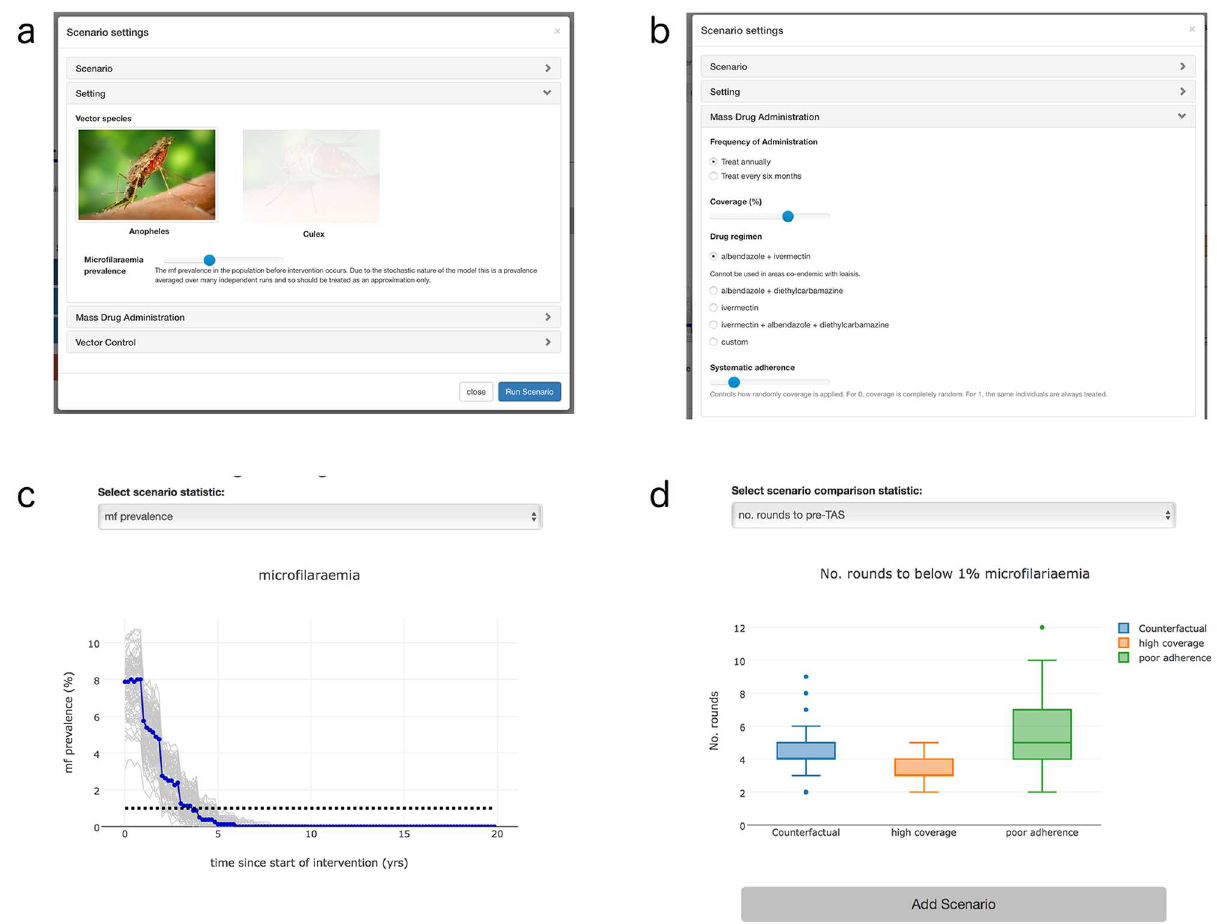
Fig 1. Overview of modelling tool. (a) Selectionpanel used to design scenario.Dominantvector species can be selectedand baseline prevalenceis controlledusing a slider. (b) Secondselectionpanel. The frequency, coverage, drug regimen,and systematic non-adherence can all be altered. Information on specific regimens also appearswhen one is selected. (c) Output results for a scenario. Medianvalue shown in blue, with separate runs in grey. Other outputs can be selected. (d) Scenario comparisonoutputs. Number of rounds to halting MDA (pre-TAS) as well as other outputs can be